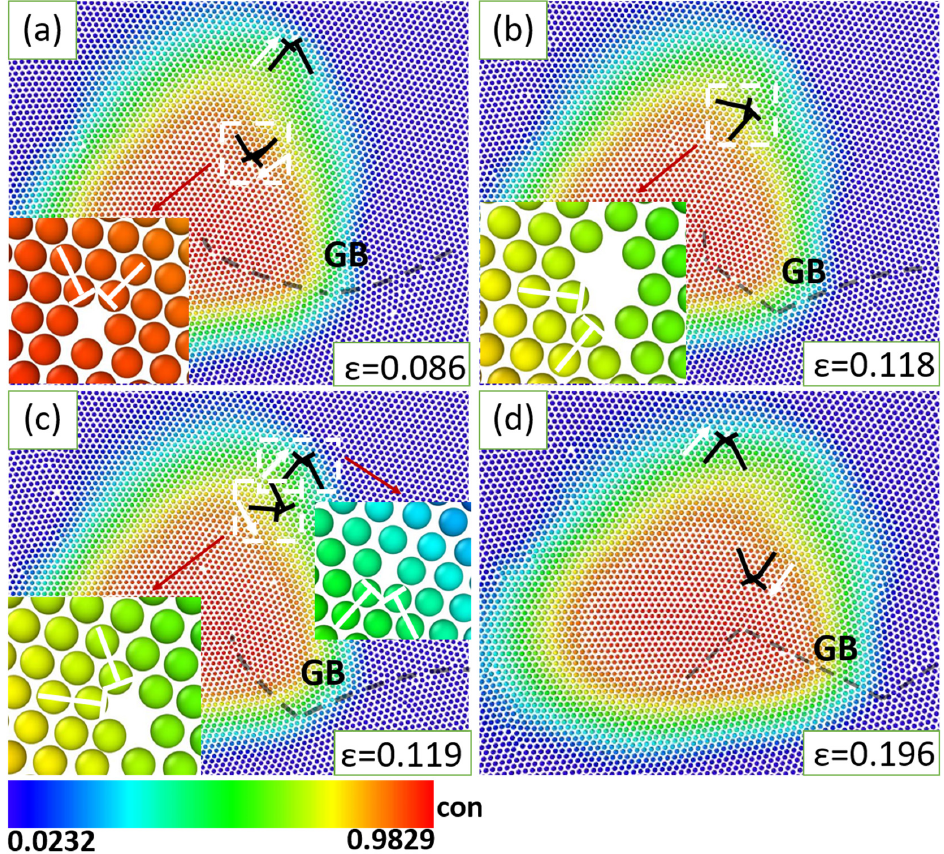
Figure 7. Emitting and separation of dislocation pairs at the semi ‐ coherent interface of different deformation strains during deformation with a strain rate ε = 10 − 4 , ( a ) ε = 0.086, ( b ) ε = 0.118, ( c ) ε = 0.119, ( d ) ε = 0.196. The white arrows mark the moving directions of dislocation, the red arrows are